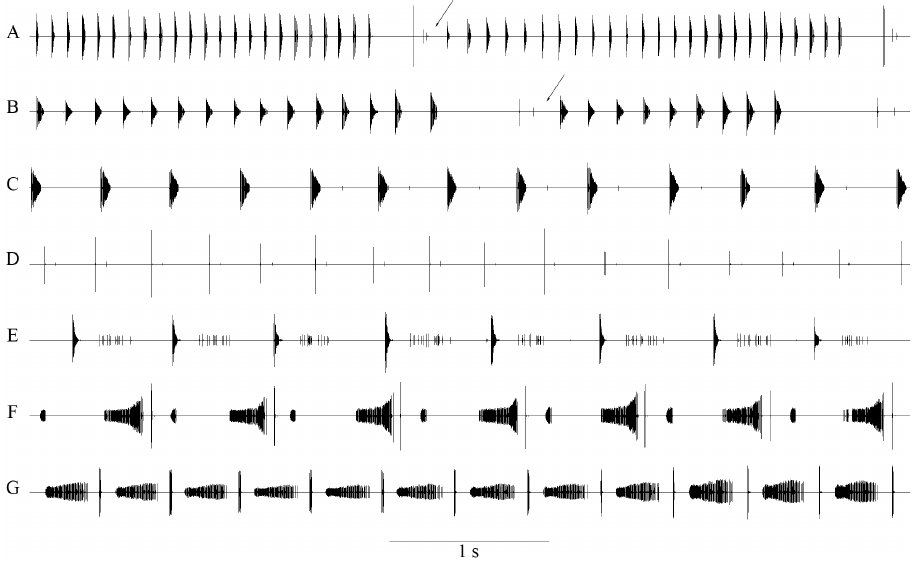
Figure 5. Oscillograms showing the typical pattern of male calling songs in each species of the Iso- phya camptoxypha species-group: A I. posthumoidalis (25°C, Bieszczady Mountains, Poland) B I. dochia (24.8°C, Gurghiu Mountains, Romania) C I. camptoxypha (25°C, Bieszczady Mountains, Poland) D I. sicula (24.8°C, Harghita-Ciceu Mountains, Romania) E I. ciucasi (25°C, Ciucaș Mountains, Romania) F I. nagyi (22.5°C, Călimani Mountains, Romania) G I. bucovinensis sp. n. (25°C, Suhard Mountains, Romania). Time scale (shown at the bottom) is the same for all oscillograms in the figure. The arrows indicate the characteristic interval separating syllable